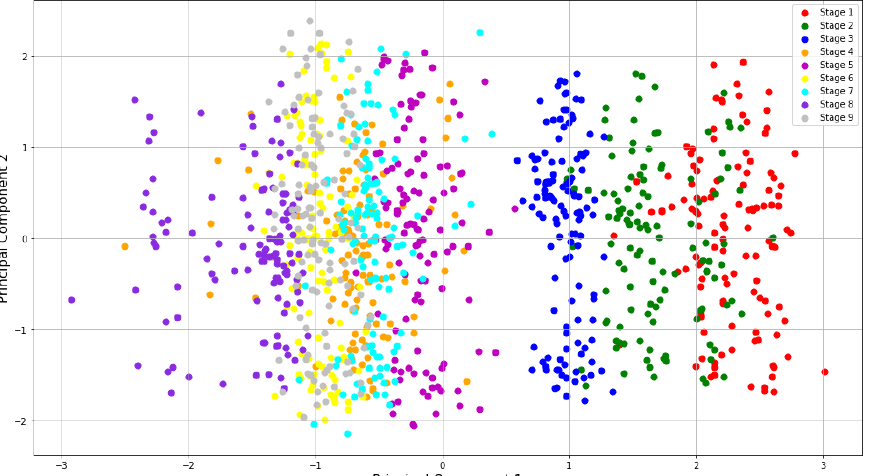
Figure 6. 2D visualization using the 2 principal components of subject 23 during the pre-test